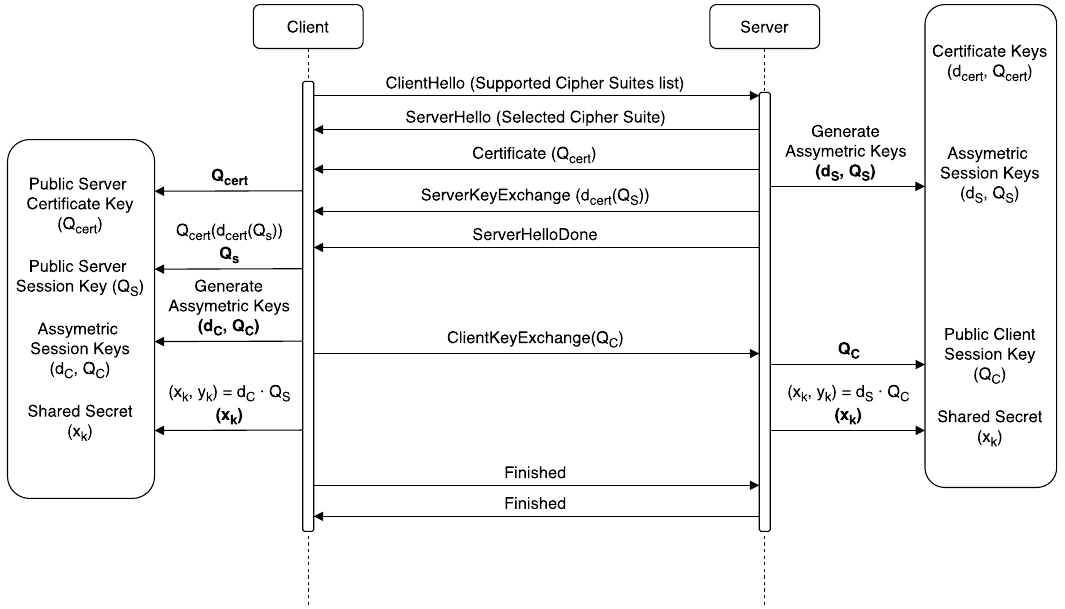
Figure 2. Transport Layer Security (TLS) Handshake procedure for ECDHE-RSA-AES128-GCM- SHA256 and similar cipher